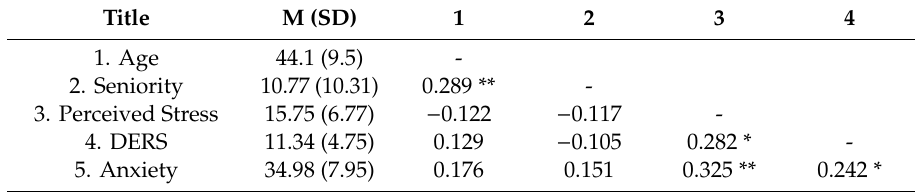
Table 6. Zero-order correlations between the variables of the study in the IARA group (POST). Table 6. Zero ‐ order correlations between the variables of the study in the IARA group (POST).